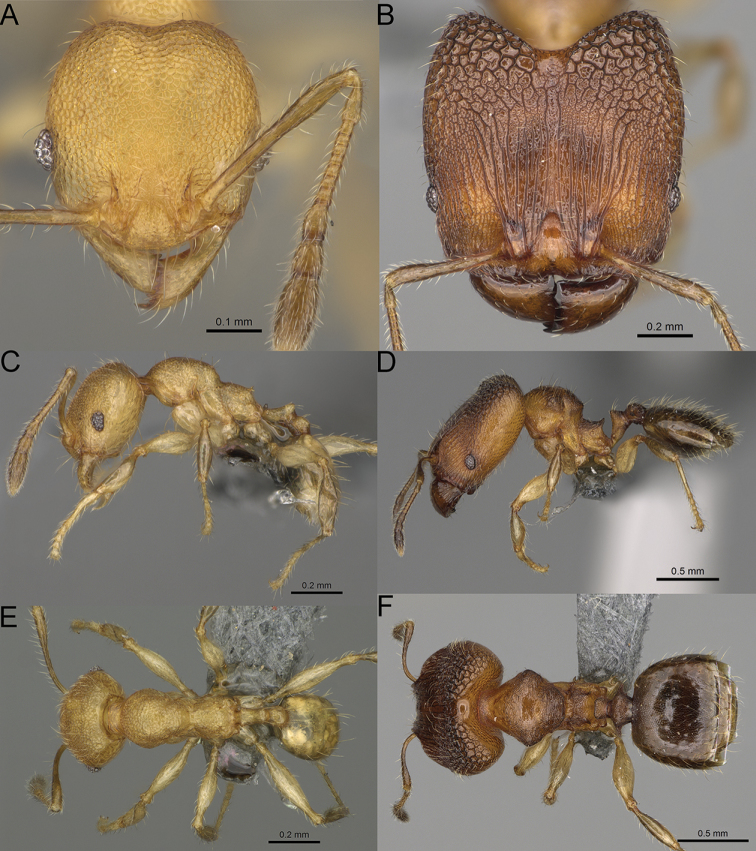
Pheidole
fisaka sp. nov., full-face view (A), profile (C), and dorsal view (E) of paratype minor worker (CASENT0923180) and full-face view (B), profile (D), and dorsal view (F) of holotype major worker (CASENT0274930).